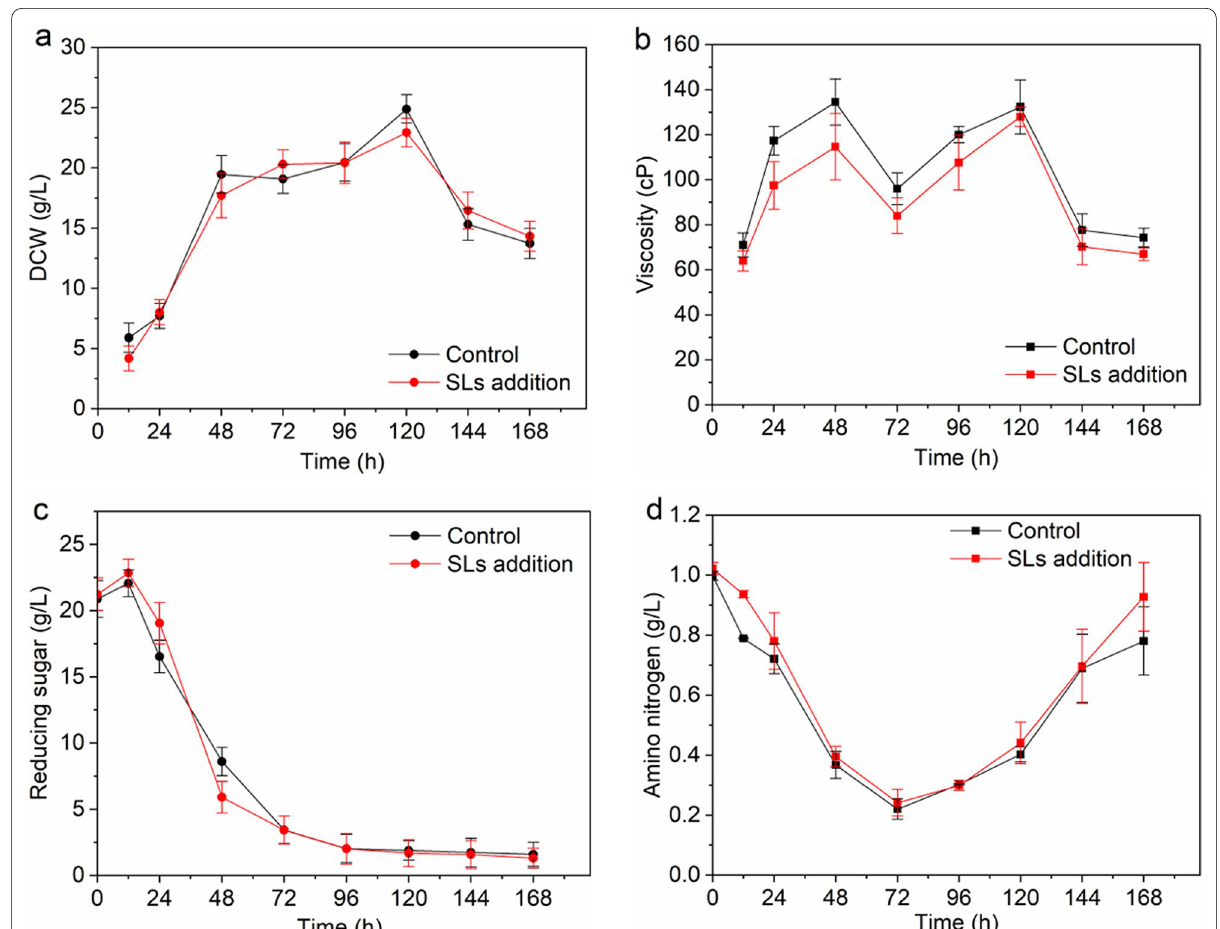
Fig. 3 Profiles of basic parameters during RML fermentation between control group and SLs addition group. a DCW; b viscosity; c reducing sugar; d amino